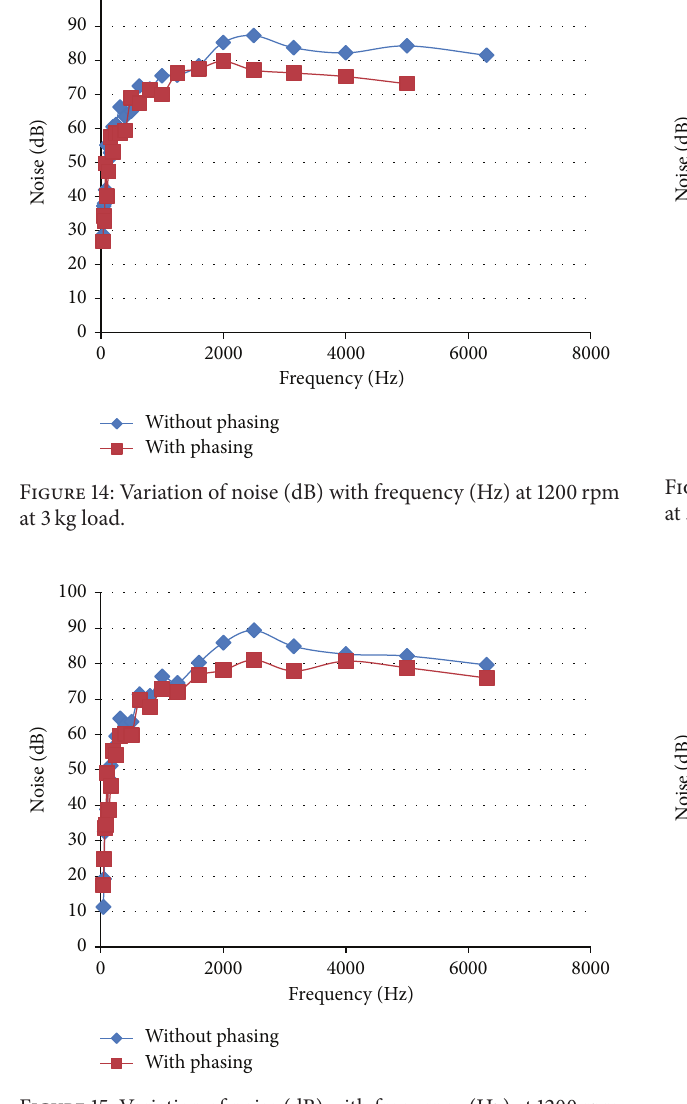
Figure 17: Variation of noise (dB) with frequency (Hz) at 1200rpm at 6kg